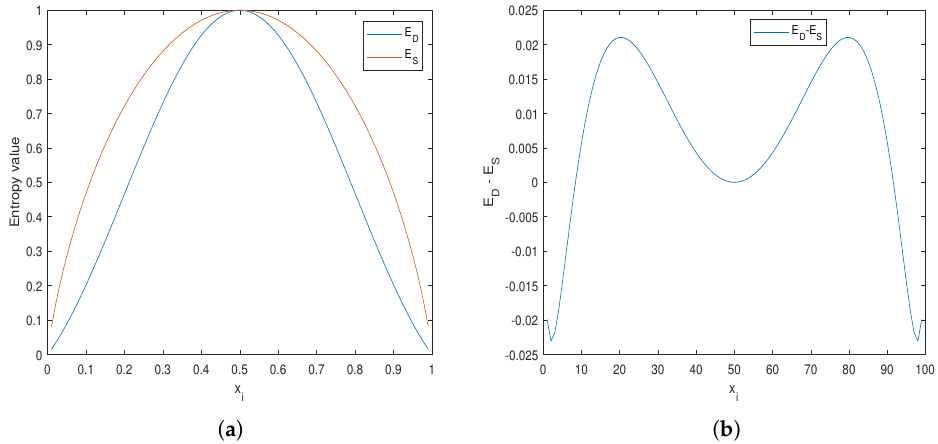
Figure 2. Comparison of the proposed entropy measure and the Shannon entropy. ( a ) Values of proposed entropy measure and the Shannon entropy for α = 1 and β = 1. ( b ) Difference between values of proposed entropy measure and the Shannon entropy for α = 6